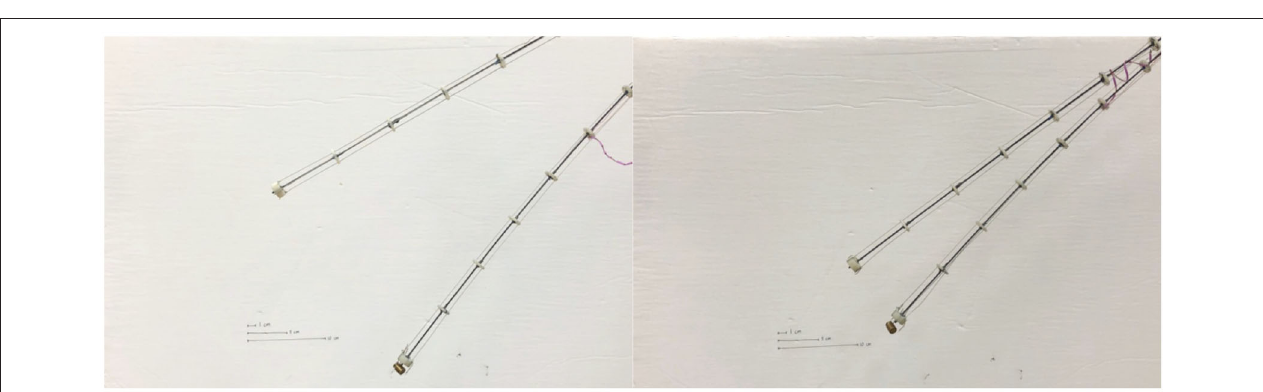
Frontiers in Robotics and AI |